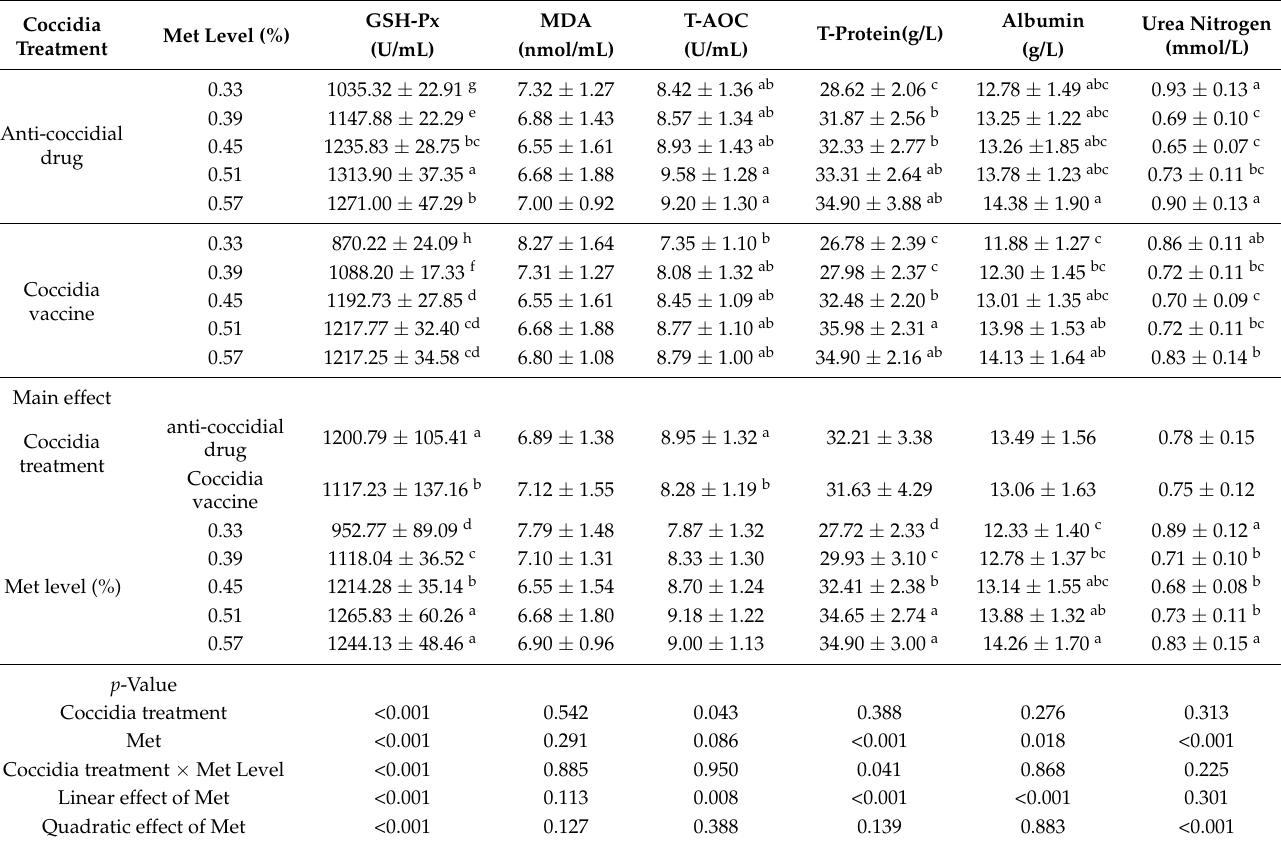
Table 5. Effect of different treatments on serum biochemical indexes of 1~21 d partridge shank